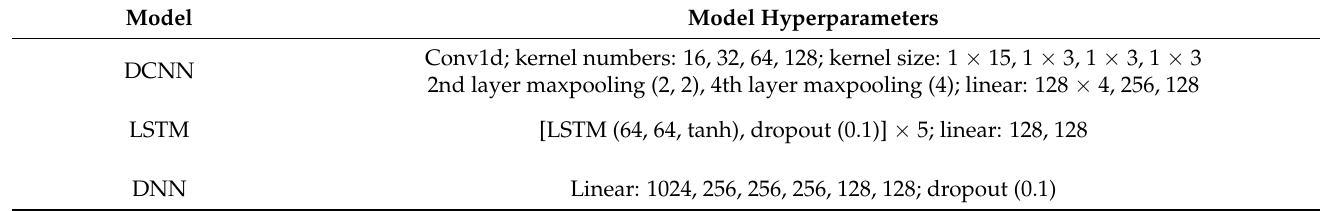
Table 6. Hyperparameters of the networks in the comparison experimental group.